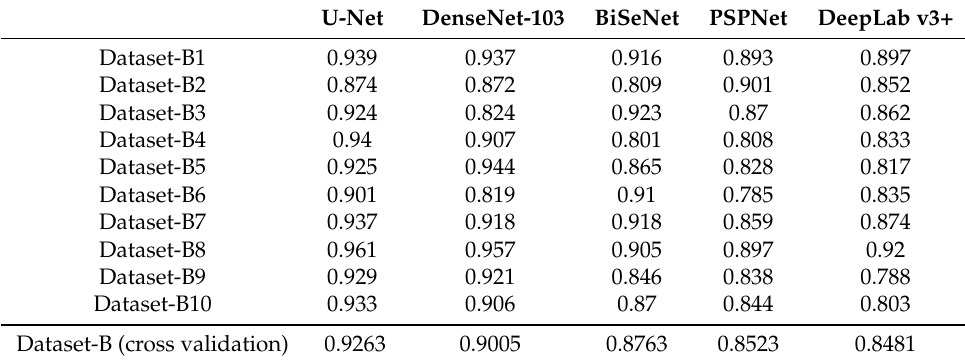
Table 8. IoU measured for every algorithm on Dataset-B (cross-validation).